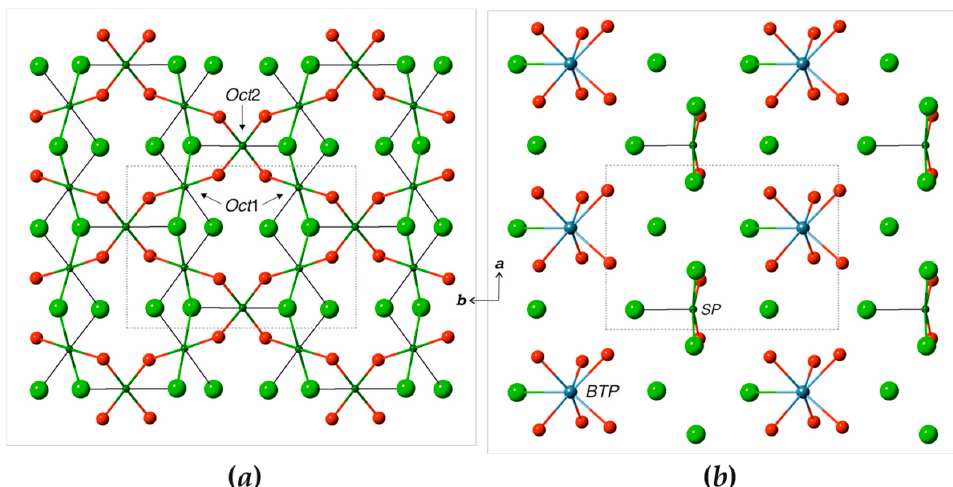
Figure 7. The projections of the A ( a ) and B ( b ) sheets in the crystal structure of dioskouriite-2 O along the c axis. Legend Figure 6. Four types of cation coordination in the crystal structures of dioskouriite-2 M and dioskou- as in Figures 5 and 6. riite-2 O (see text for details). Legend as in Figure 5. Oct , BTP and SP mean octahedral, bicapped trigonal prismatic and (distorted) square pyramidal coordination of cation, respectively.